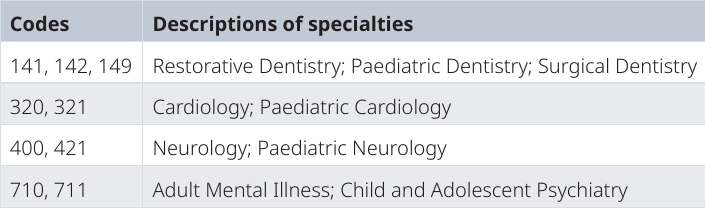
Table 3. Related paediatric and adult consultant main specialties.